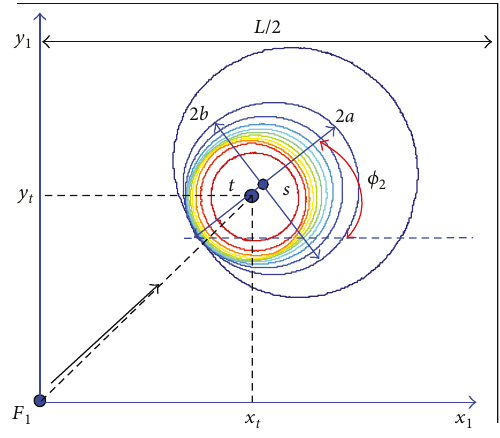
Figure 5: Geometrical parameters of the focal spot on the plane receive.